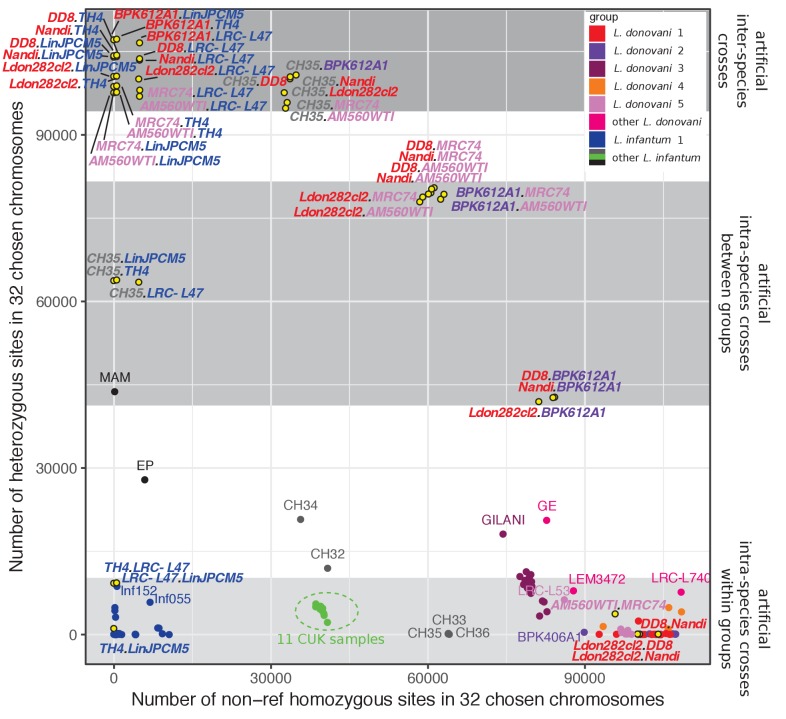
Heterozygosity of artificial F1 hybrids.Artificial F1 hybrids were generated by matching ten almost entirely homozygous samples across the phylogeny. Chromosomes 2, 8, 22 and 31 were excluded since they did not satisfy these criteria. The number of non-reference homozygous sites is plotted against the number of heterozygous sites. The plot includes real samples as well as artificial hybrids. Groups are indicated by colours. Artificial hybrids are displayed by yellow dots surrounded by black circles and their names are written in bold italics indicating the names of the combined samples in their respective group colours separated by a black dot. Grey shaded areas indicate heterozygosity levels that are spanned by different levels of artificial hybrids including inter-species and intra-species hybrids between and within identified groups.